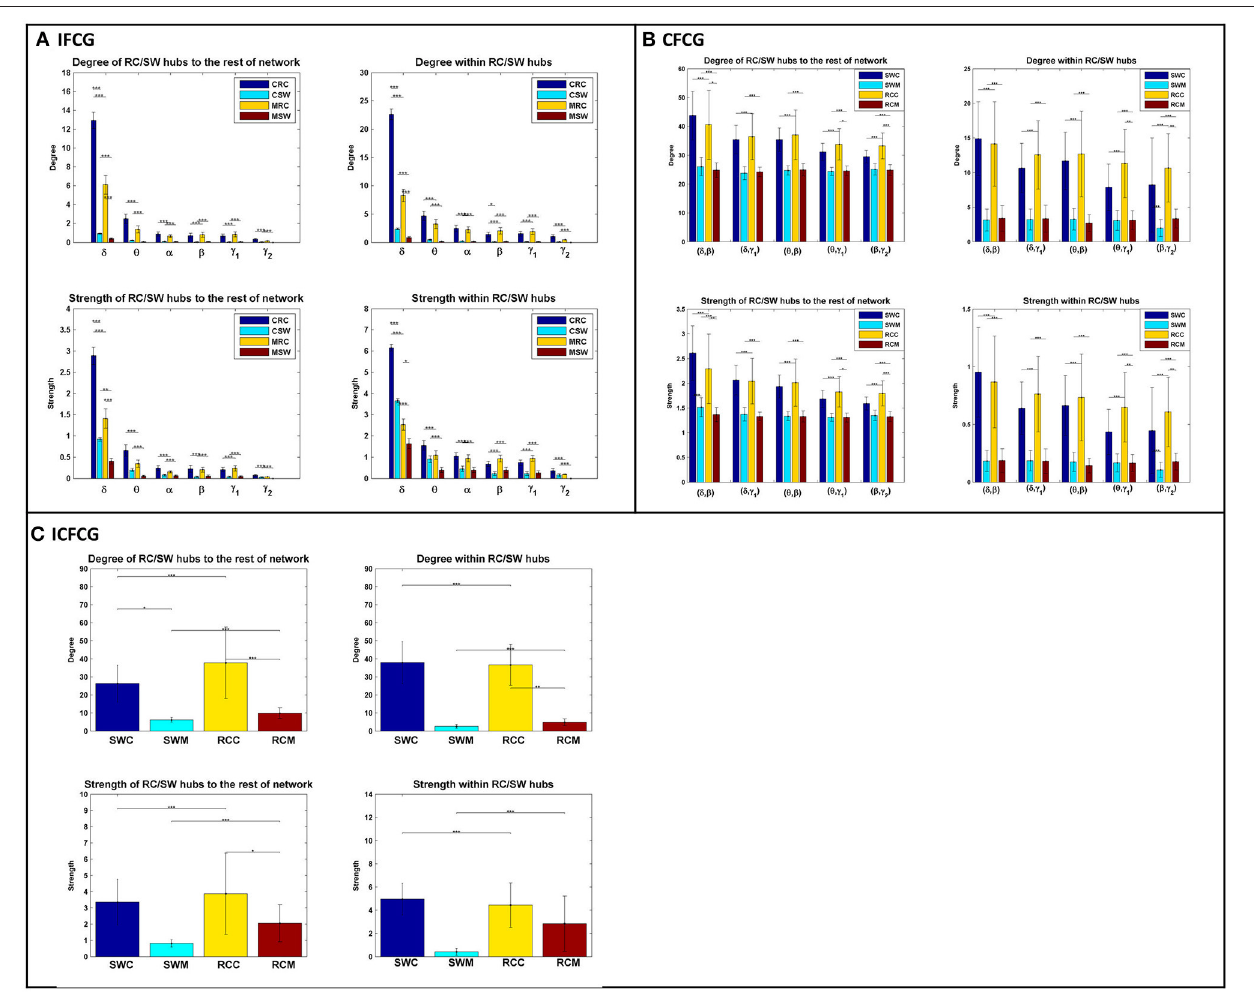
FIGURE 4 | Representation of the averaged degree and strength of the RC/SW hubs (i) with the rest of nodes networks and (ii) within RC/SW nodes across each group (acronyms follow the definition in capture of Figure 3 ). For (A) IFCG, (B) CFCG, and (C) ICFCG. All comparisons (paired test linked by *) reach statistical significance ( p -value: * < 0.05; ** < 0.01, and *** <